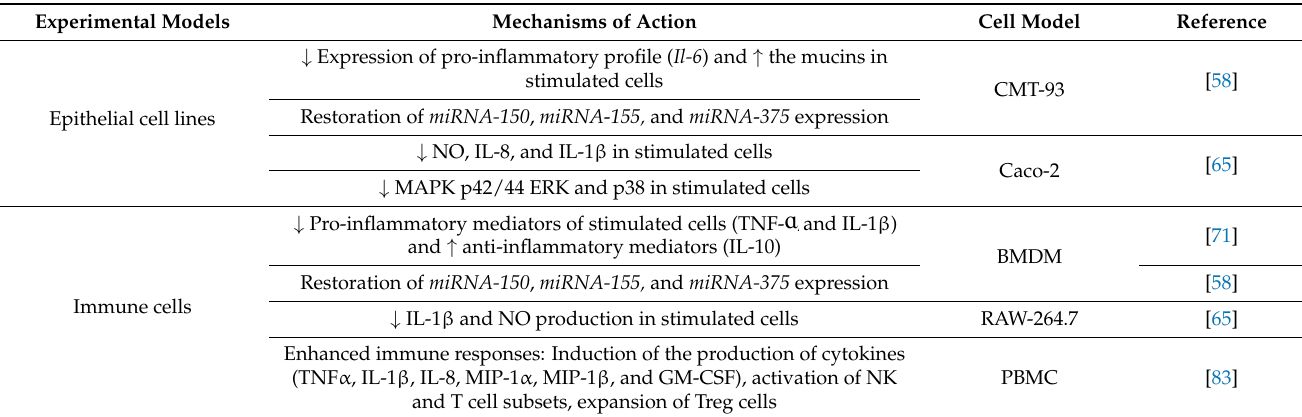
Table 3. In vitro studies: mechanisms of action of L. fermentum CECT5716.